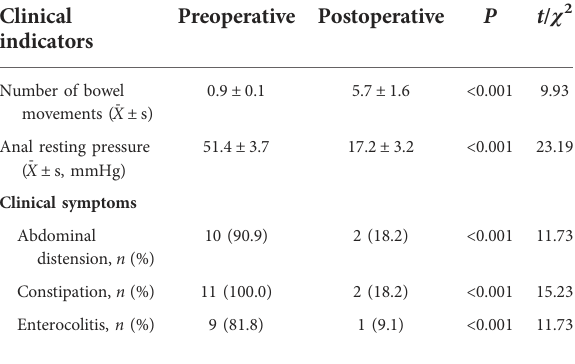
TABLE 4 Outcomes after internal sphincter myectomy ( N